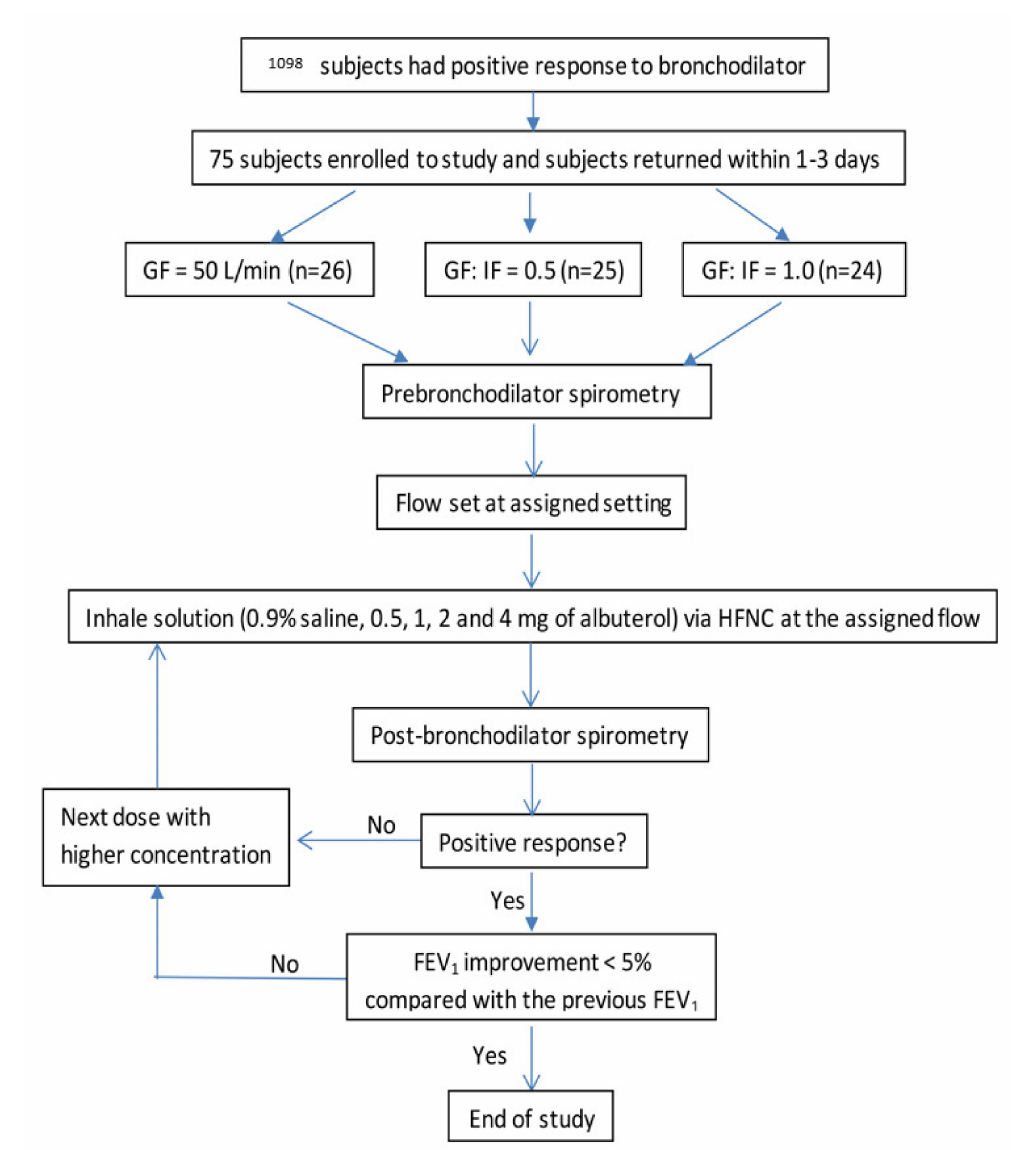
Figure 1. Study flowchart. GF, gas flow; IF, patient inspiratory flow; HFNC, high-flow nasal cannula; FEV 1 , forced expiratory volume in the first